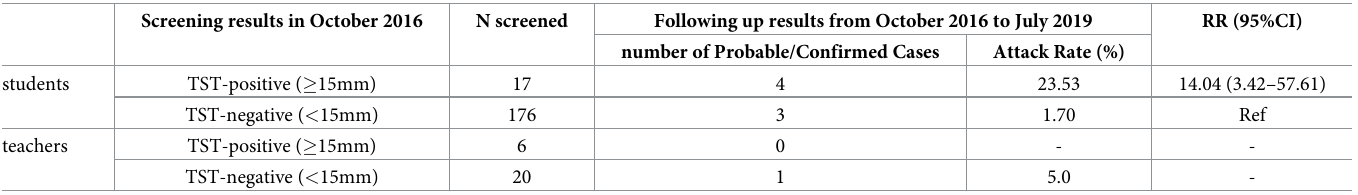
Table 3. Following up results of 193 students and 26 teachers in the same grade as the index case-student: Zhejiang Province, China, 2016–2019 a . Screening results in October